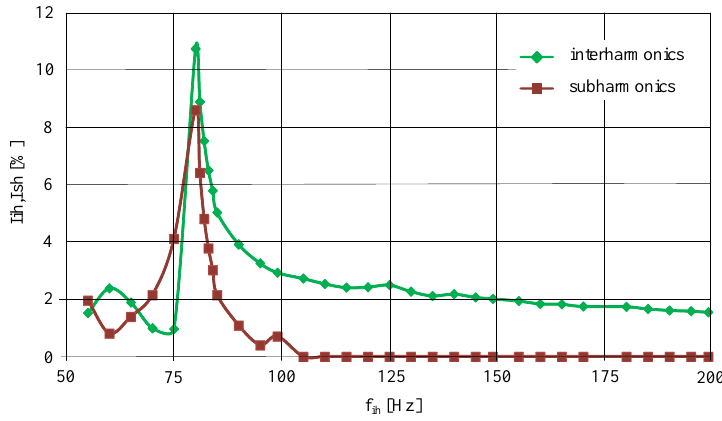
Figure 15. Measured current interharmonics and subharmonics (related to the rated current) vs. the frequency of voltage interharmonics for motor 4-p4 coupled with the DC generator.